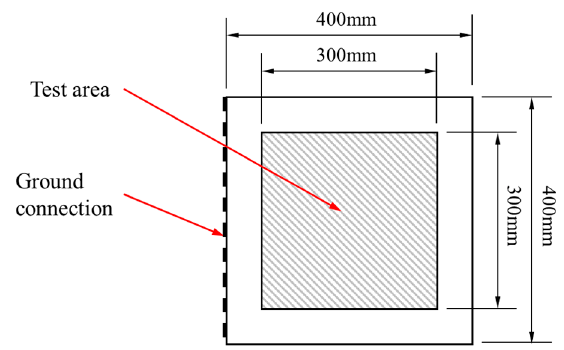
Figure 6. Schematic of specimen of lightning protection test.